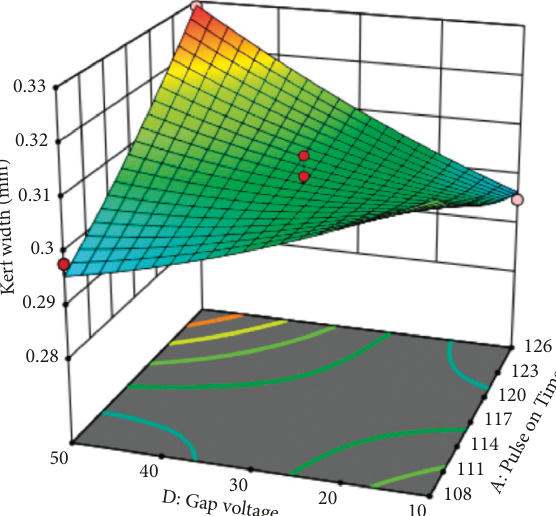
Figure 9: Residual on kerf width observations.